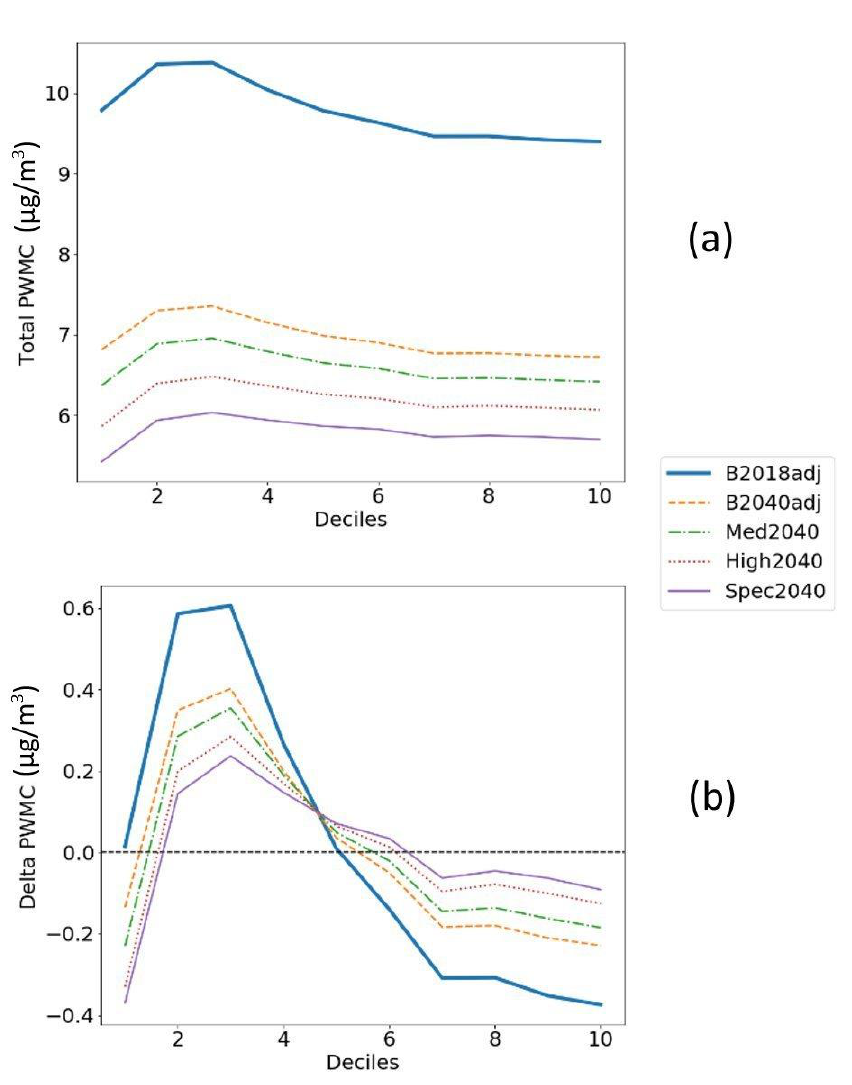
Figure 11. ( a ) PWMC for each deprivation decile and ( b ) the Delta PWMC for England for each deprivation decile for B2018adj and 2040 scenarios.